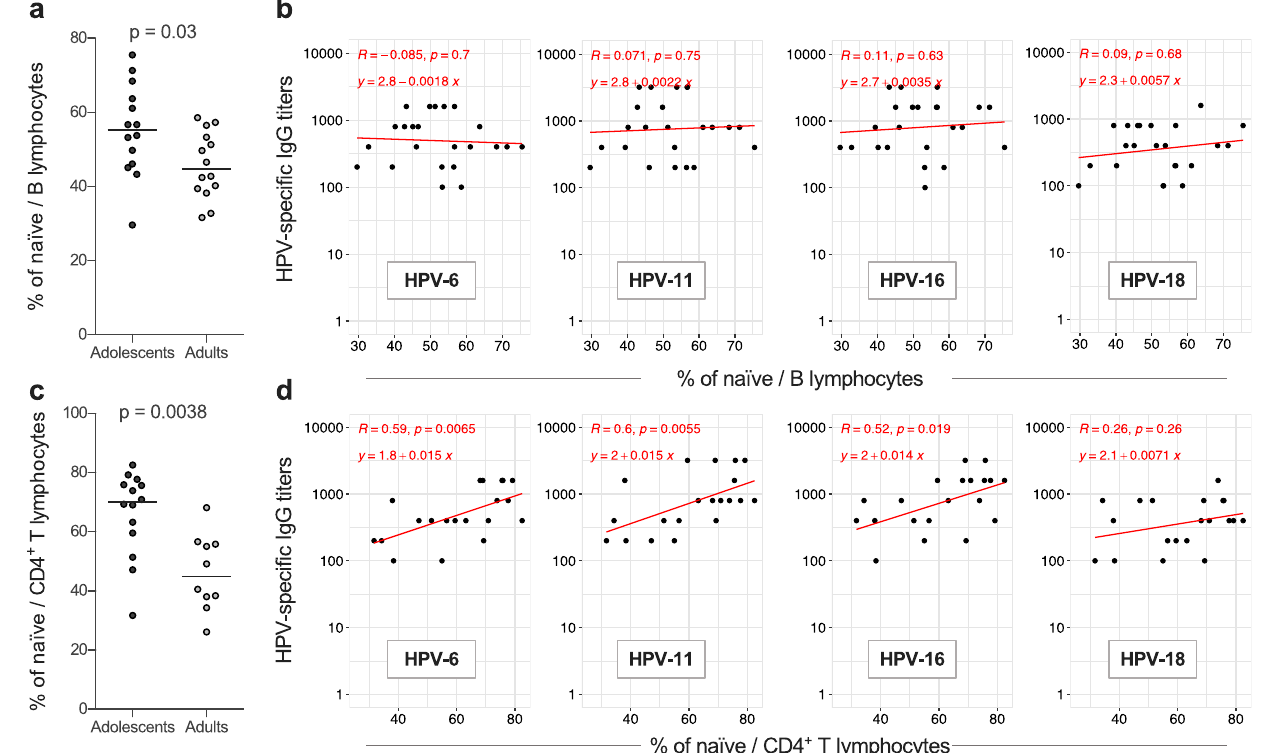
Fig. 7 Effect of age on the quantity of naïve lymphocyte subsets. a , b Percent of naïve B cells on total B lymphocytes ( a , each dot represents a single donor and lines the median) and their correlation ( b ) with HPV-6, HPV-11, HPV-16 and HPV-18-speci fi c IgG titers (regression lines and their equations are shown); n = 28 (14 adolescents and 14 adults). c , d Percent of naïve CD4 + T cells on total CD4 + T lymphocytes ( c , each dot represents a single donor and lines the median) and their correlation ( d ) with HPV-6, HPV-11, HPV-16, and HPV-18-speci fi c IgG titers (regression lines and their equations are shown); n = 24 (14 adolescents and 10 adults). Samples are from the “ Early cohort ” . Statistical signi fi cance was determined by the Mann – Whitney test and Spearman ’ s rank correlation and all p -values are